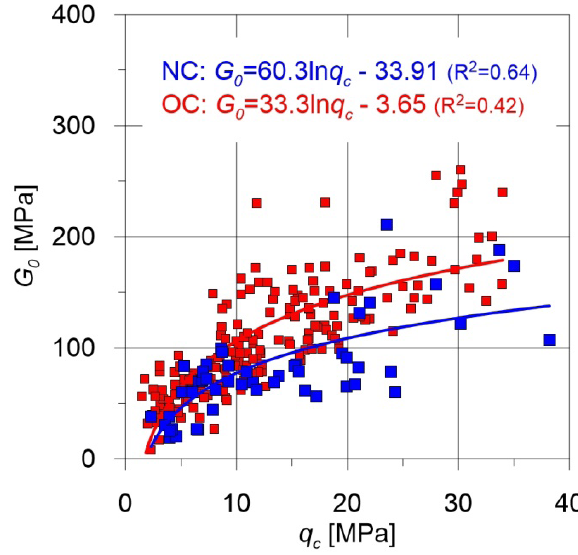
Figure 8: The correlation between modulus G q taking into account the division into normally consolidated (blue) c and overconsolidated (red)